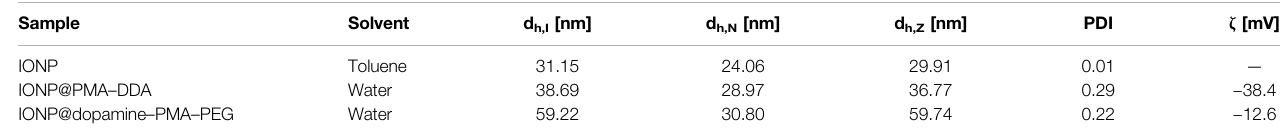
TABLE 1 | The hydrodynamic diameter d h of 18 nm IONPs as measured byDLS before and after polymer coating. Values were obtained from the intensity distribution (d h,I ), the number distribution (d h,N ), and the Z-average (d h,Z ). PDI refers to the polydispersity index. Also the mean value of the zeta potential ζ is provided.